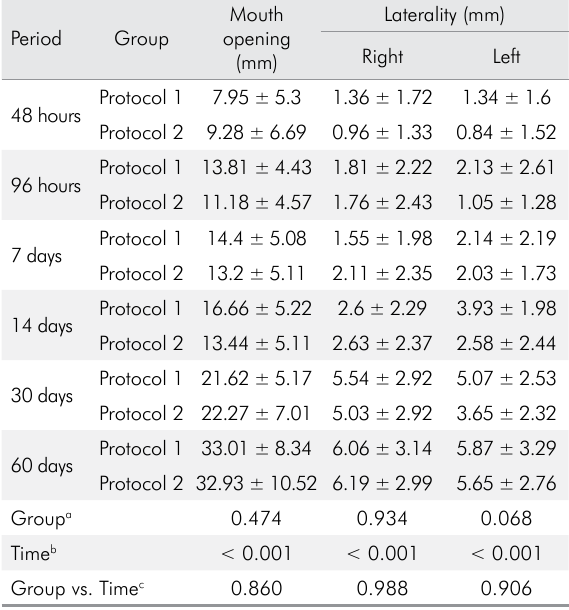
Table 5. Mandibular movement measurements in mm, mean and standard deviation – ERAS group (Protocol 1) and control group (Protocol 2).